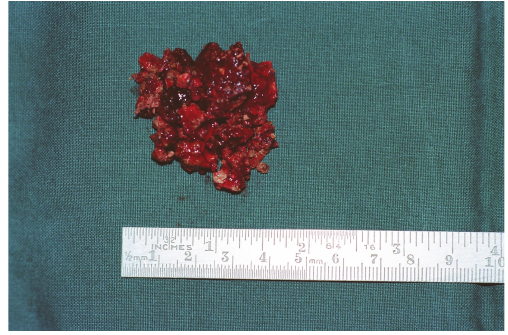
Figure 4: Removed